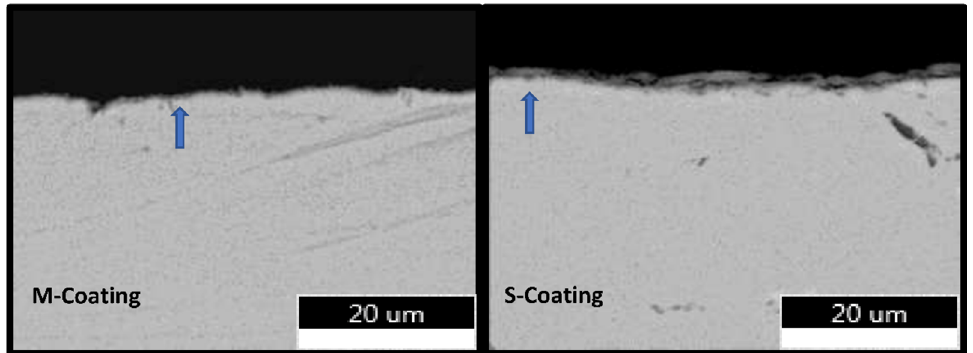
Figure 5. SEM cross-section images showing the thin-film perovskite coatings grown on the surface of M-coating and S-coating samples. The arrows indicate the position of the EDX line scans.